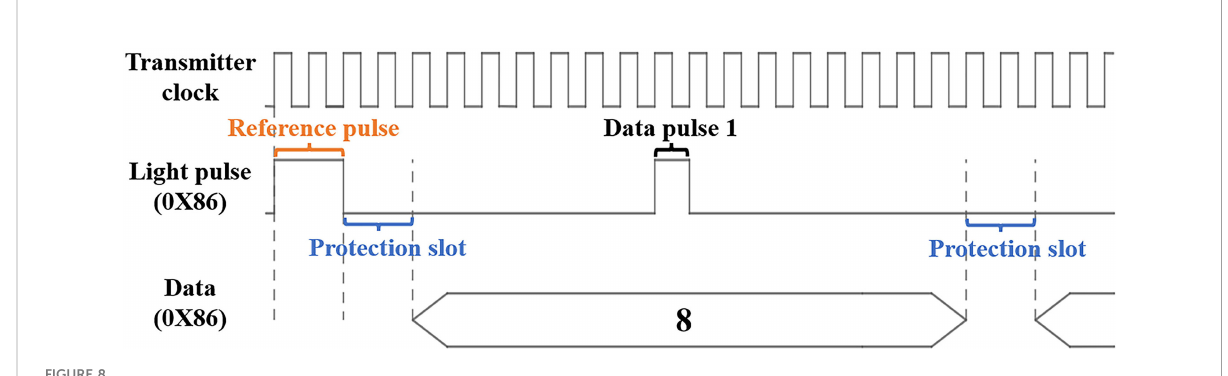
FIGURE 8 Schematic diagram of the improved 16-PPM